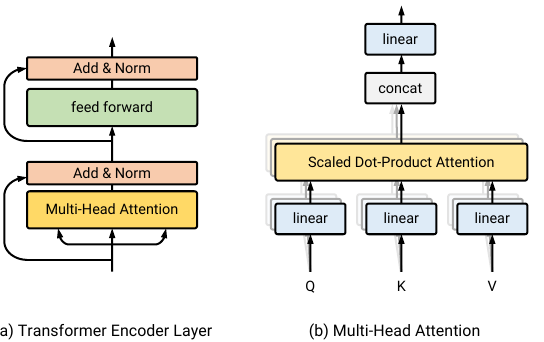
Figure 4. ( a ) The architecture of an transformer encoder layer. ( b ) The architecture of the multi-head attention